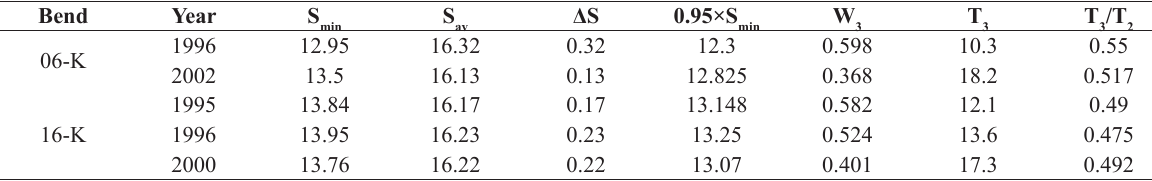
Table 9. Estimated values of ECW rate and remaining lifespan for bends obtained according to formula (10). Bend